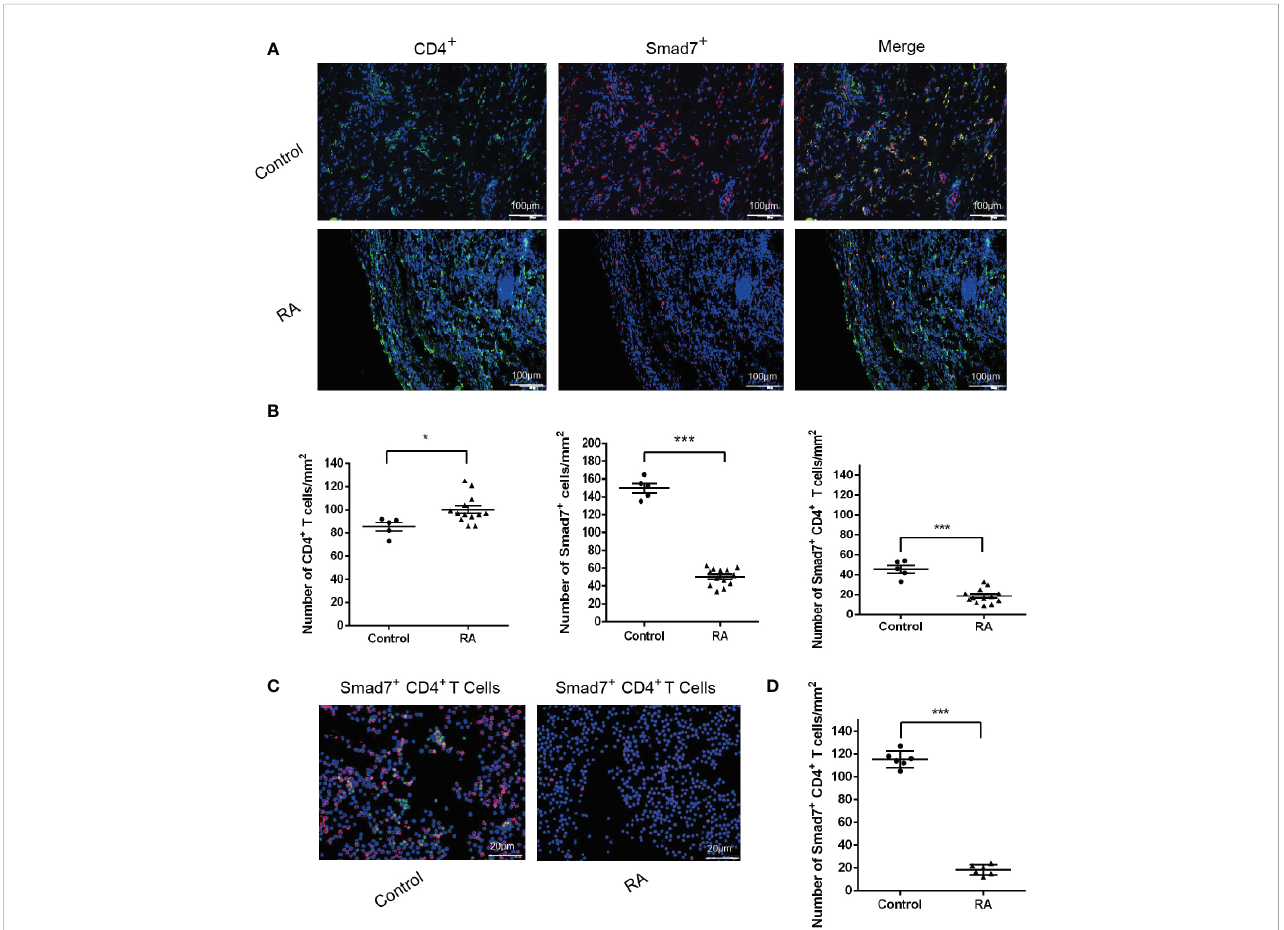
FIGURE 1 Immuno fl uorescence detects expression of Smad7 by CD4 + T cells from synovial tissues and peripheral blood of RA patients: (A, B) Two-color immuno fl uorescence and quantitative analysis of CD4 + , Smad7 + and Smad7 + CD4 + cells in the synovial tissues of RA patients and health controls. (C, D) CD4 + T cells were sorted from peripheral of RA patients and health controls. More than 85% cells were con fi rmed to be CD4 + T cells by fl ow cytometry. The Smad7 immuno fl uorescence and quantitative analysis were conducted in the sorted CD4 + T cells from RA patients and health controls. Each dot represents one individual and data are the mean ± SD. * P < 0.05, *** P < 0.001 compared between